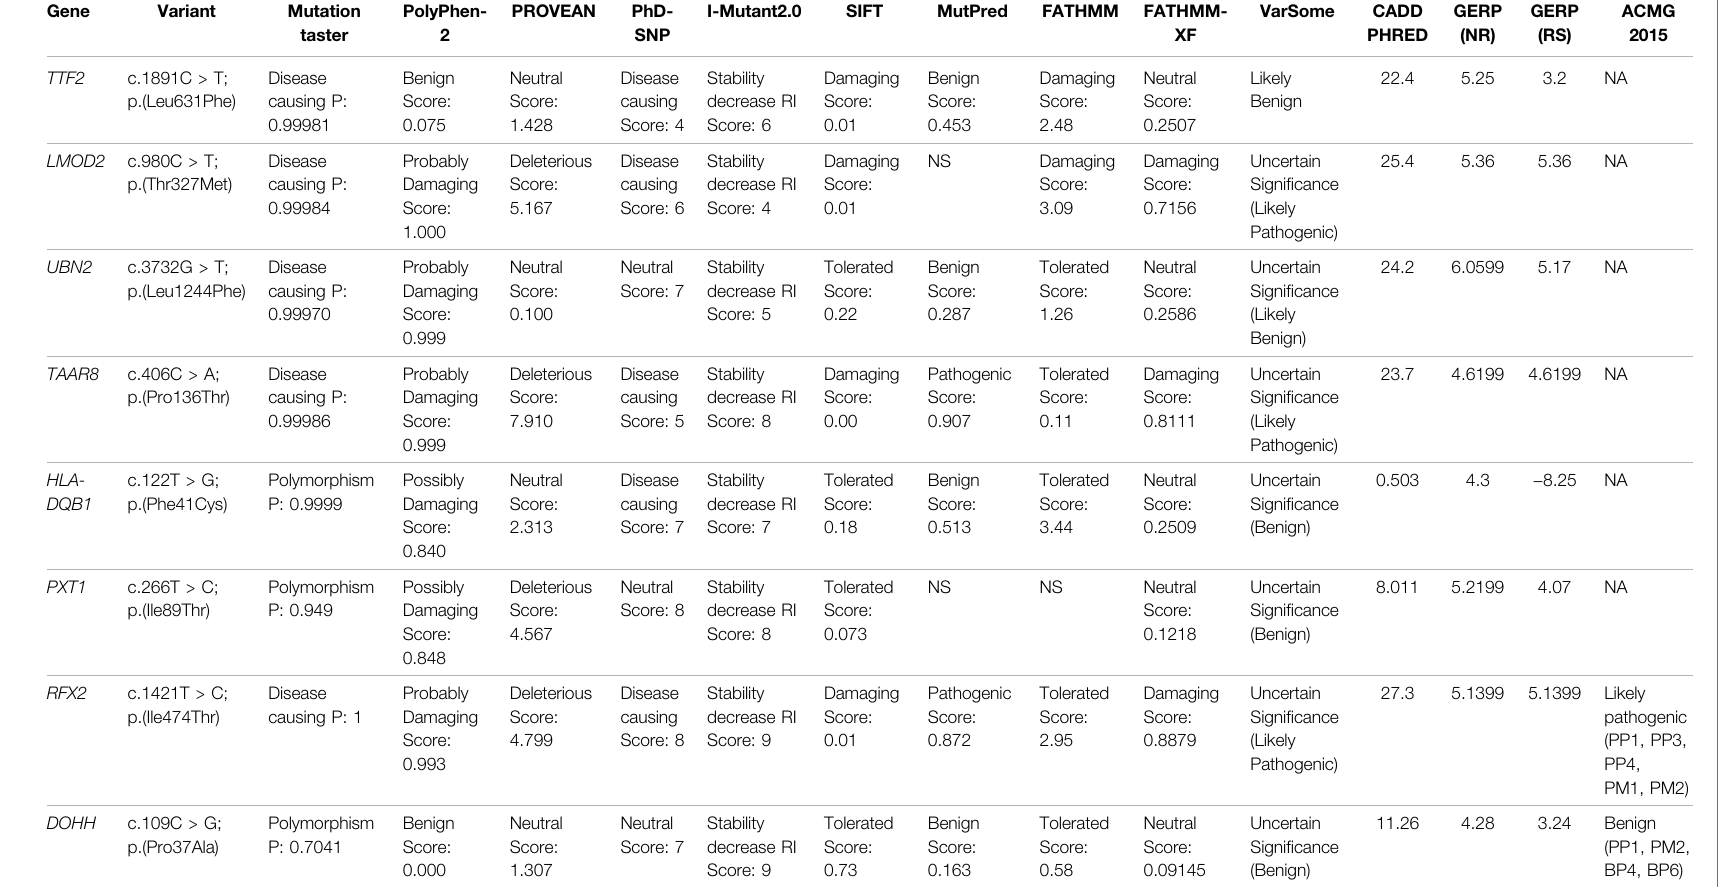
TABLE 2 | In silico analysis of the coding variants with scores by using the various online pathogenicity prediction tools. Gene